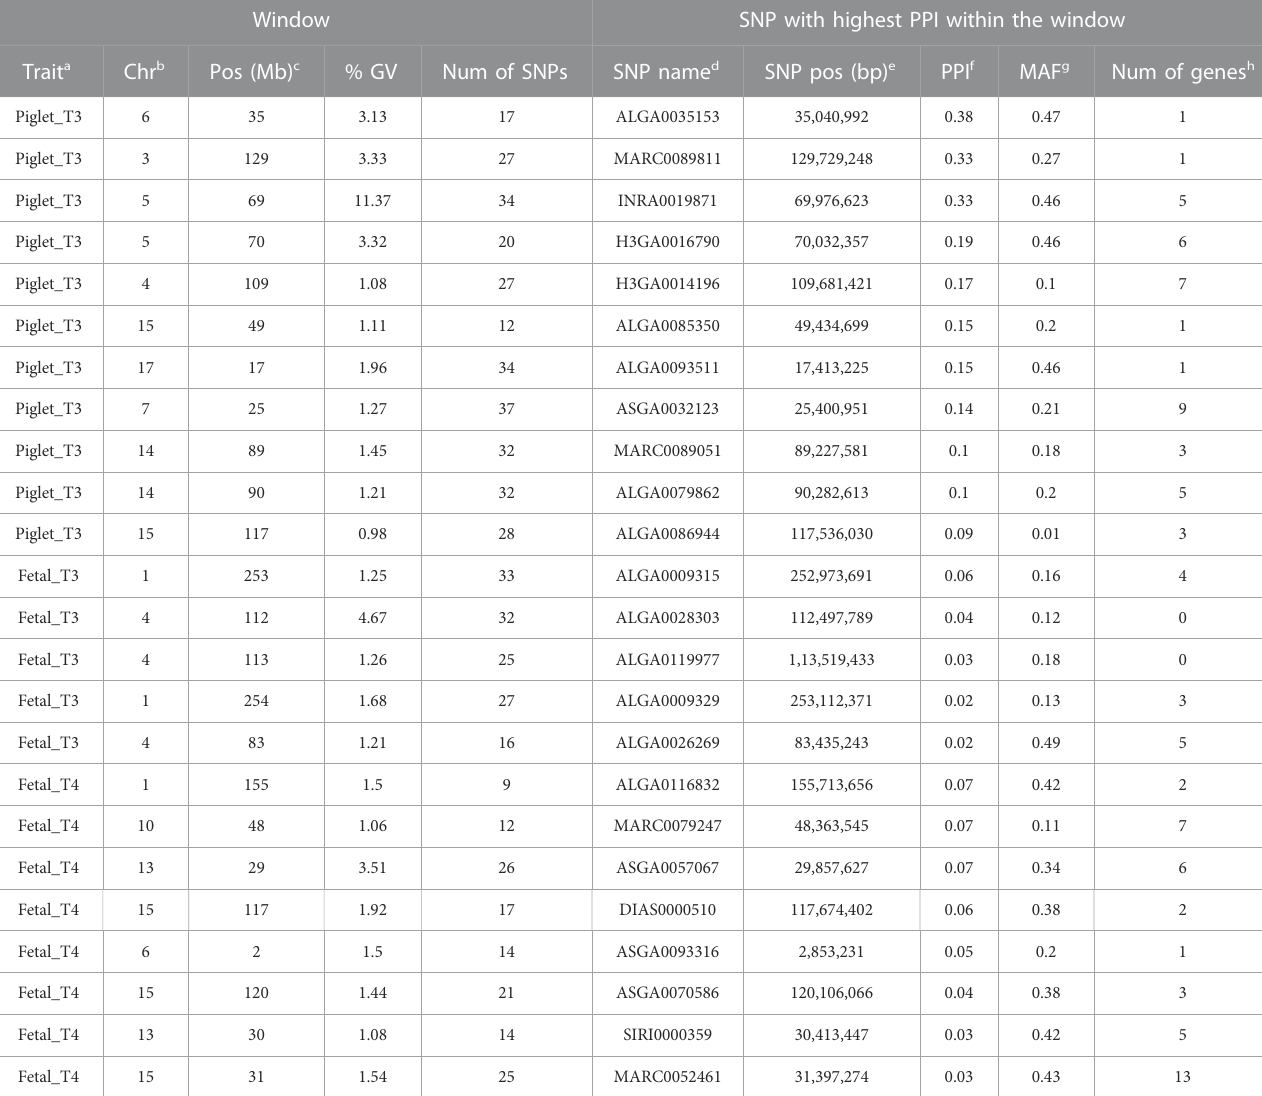
TABLE 4 Summary of GWAS results for piglet_T3, fetal_T3, and fetal_T4 with SNP information for each 1-Mb window with more than 1% of the GV. Window SNP with highest PPI within the